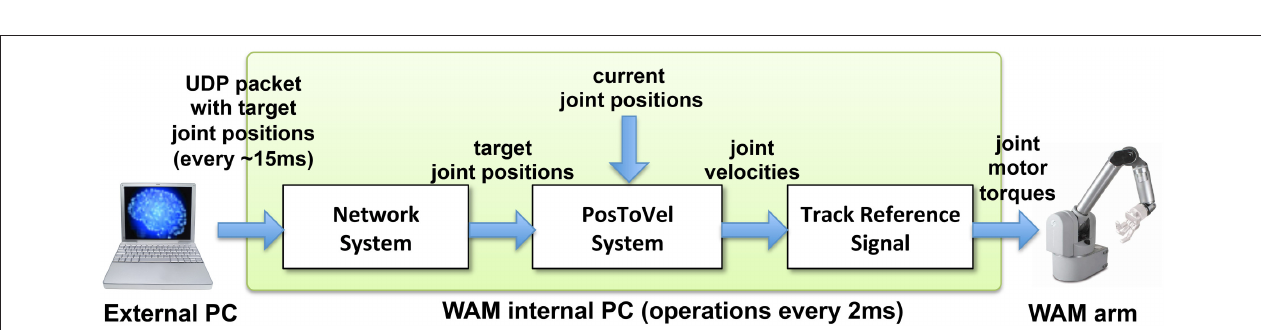
FIGURE 3 | Block diagram of the information flow in the system. Blocks represent the four main software components of the system: NEURON biomimetic model, C++ virtual arm, C ++ robot arm code, and the Python interface, responsible for linking all the previous. Arrows represent the information flow between software components, and numbers indicate the order in which these occur.